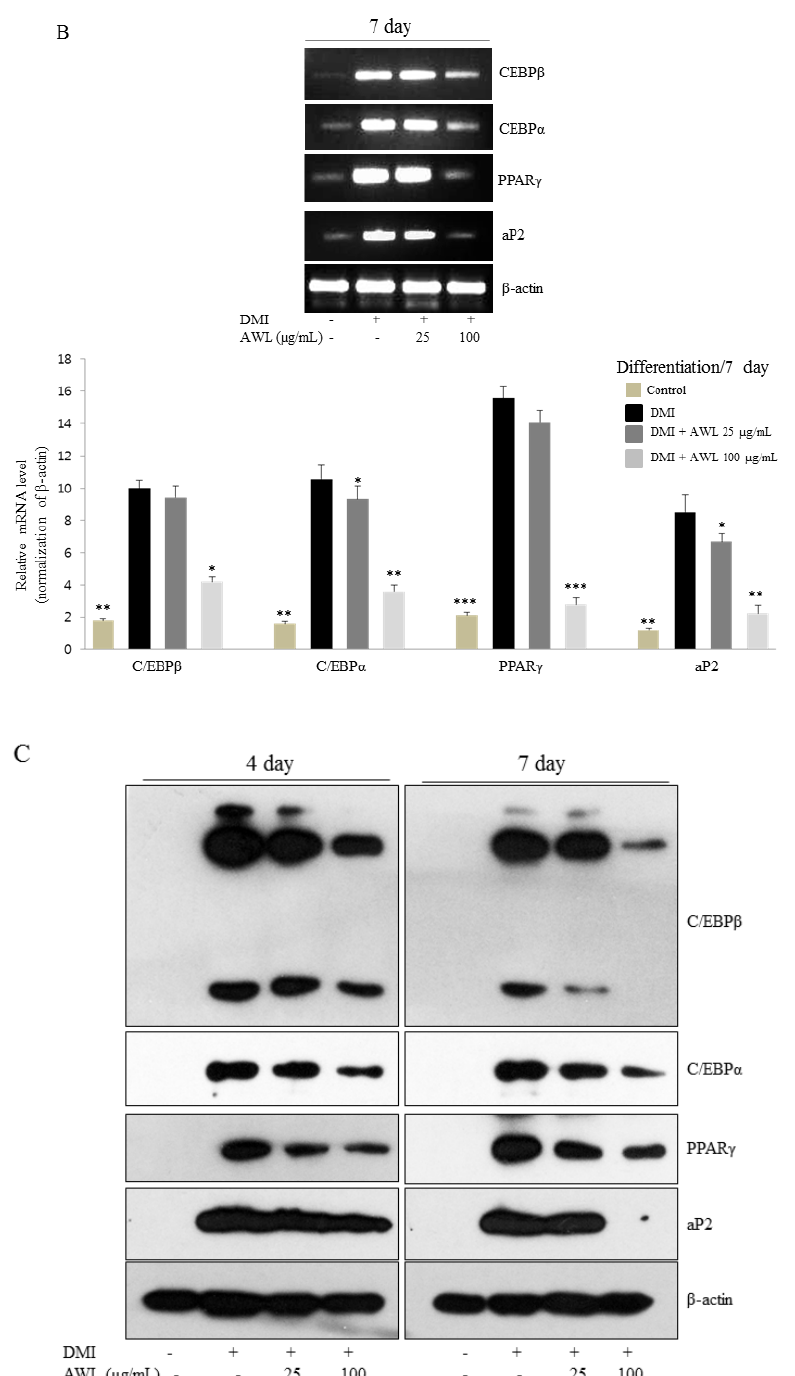
Figure 2. Effects of AWL on adipogenic factors in 3T3-L1 adipocytes. ( A ) AWL decreased the expression of adipogenic factors in 3T3-L1 adipocytes at day 4 by RT-PCR. Similar results were obtained by three independent experiments; ( B ) AWL inhibited the expression of adipogenic factors in 3T3-L1 adipocytes at day 7 by RT-PCR. The figure is representative of three independent experiments with identical results. Optical density analysis was performed to quantify the levels of mRNA expression with β -actin as loading control. * p < 0.05, ** p < 0.01, and *** p < 0.001 compared with DMI group. ( C ) AWL inhibited the expression of genes related to adipogenesis and lipogenesis in 3T3-L1 adipocytes at days 4 and 7 as determined by a Western blot